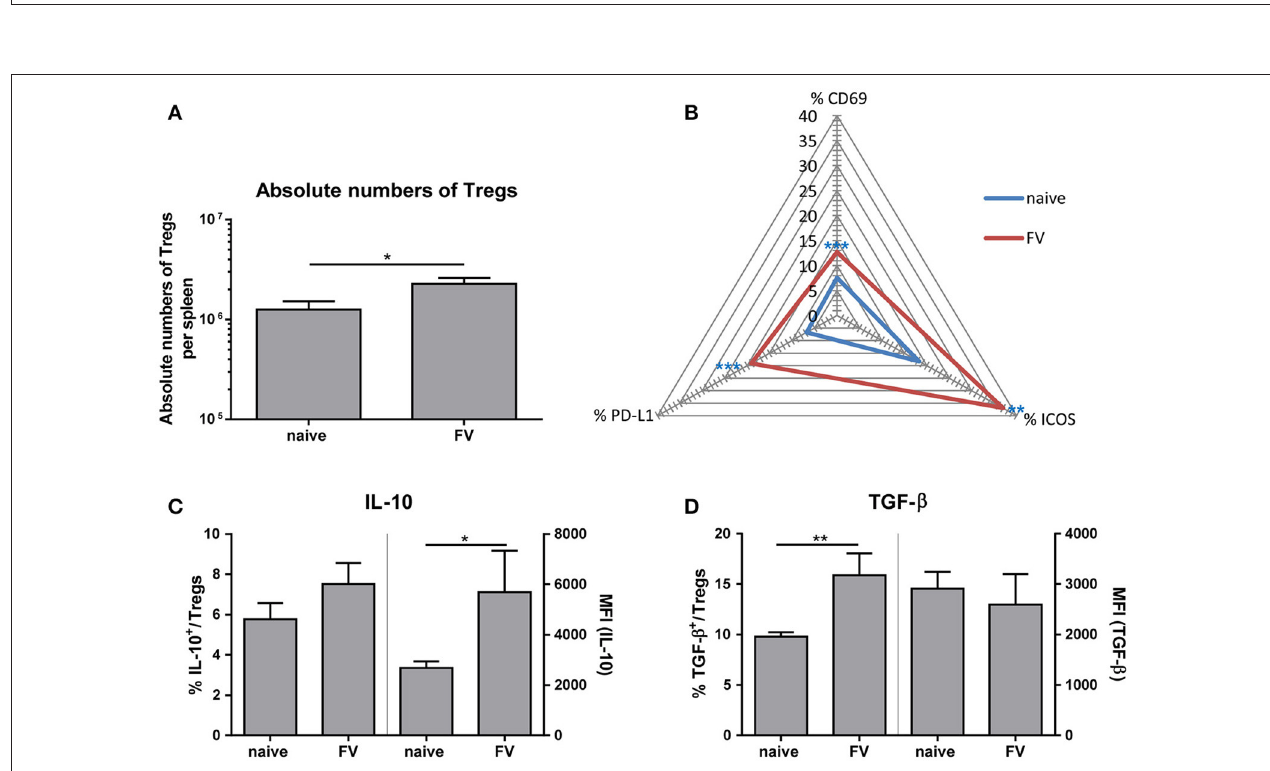
FIGURE 4 | Phenotype of Tregs during an acute FV infection. Mice were infected with FV and spleen cells were analyzed at 3 dpi. Uninfected mice were used as control. Absolute numbers of CD4 + Foxp3 + Tregs were analyzed in (A) (naïve n = 18, FV n = 26) and are displayed by mean values ( ± SEM). Statistically significant differences were analyzed by Mann-Whitney test. Activation of Tregs was analyzed by multi-parametric flow cytometry and mean percentages are shown in a spider plot (B) . At least 6 values from two independent experiments were used for the analysis (CD69: naïve n = 14, FV n = 19; PD-L1 and ICOS: naïve n = 8, FV n = 6). Statistically significant differences were analyzed by Mann-Whitney test (CD69) or unpaired t -test (ICOS, PDL-1). The percentages (left axis) as well as the mean fluorescence intensity (MFI, right axis) of IL-10 + or TGF- β + Tregs are shown in (C) (naïve n = 9, FV n = 6) and (D) (naïve n = 9, FV n = 6). A minimum of 6 animals from two independent experiments were used for the analysis. Mean values are displayed, with SEM indicated by error bars. Statistically significant differences were analyzed by an unpaired t -test and are indicated as follows: * p < 0.05, ** p < 0.01, *** p < 0.001.